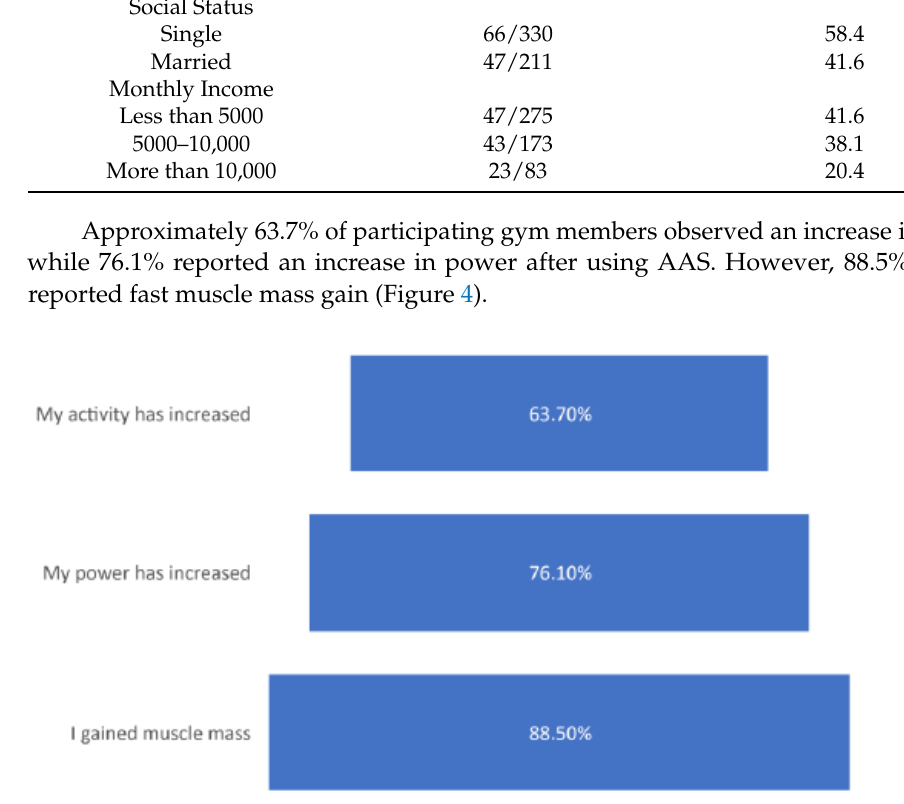
Figure 3. Sources of steroids.